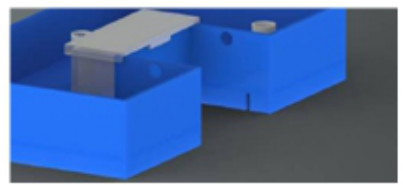
Figure 12. Cut outs in the grow bed